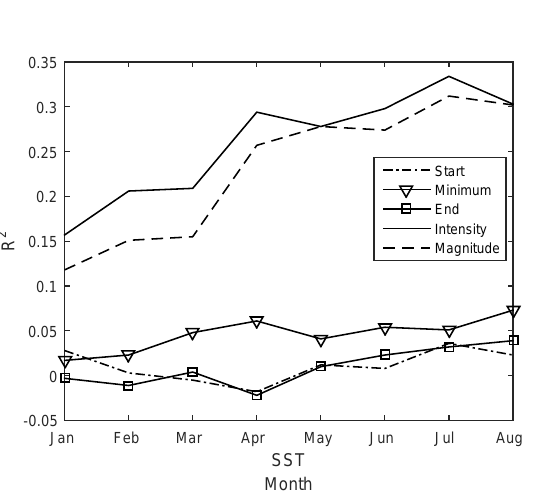
Figure 7. Goodness index ( R 2 ) estimated as the average of the Pear- son correlation between synthetic time series generated by cross- validation models and the observed MSD features per